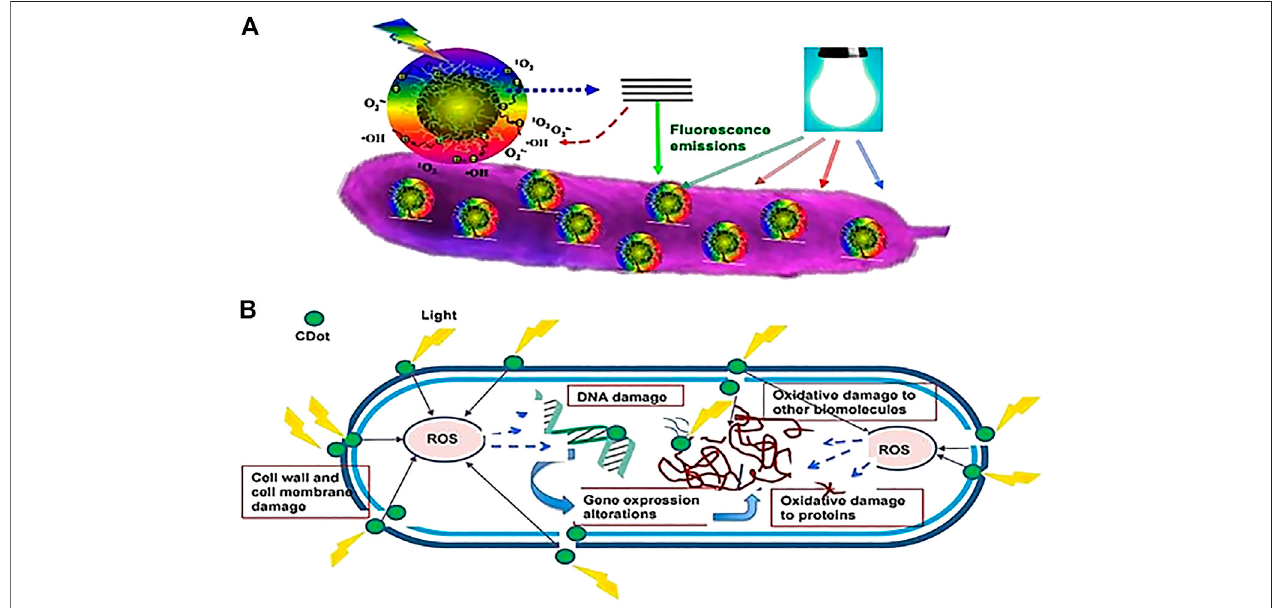
FIGURE 6 | Cartoon diagram on the mechanism of action for photoactivated antibacterial activity of C-Dots (A) Adhesion of C-Dots to the bacterial surface and visible-light-induced ROS generation (B) Intracellular ROS causes damage to the bacterial cell (Dong et al., 2020).